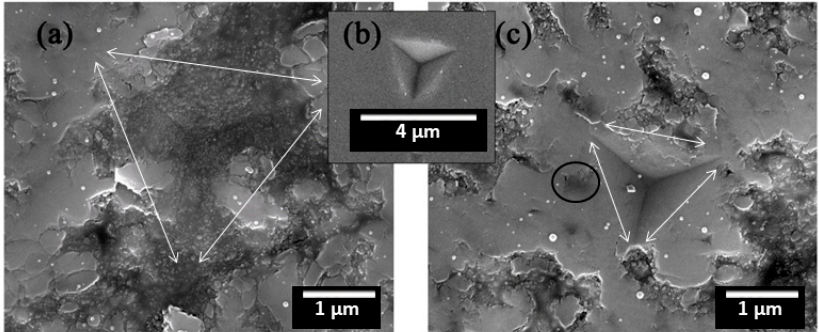
Figure 7. Morphologies of nano-indents: ( a ) region of agglomerated particles, ( b ) substrate-304 SS and ( c ) region of fully melted splats.